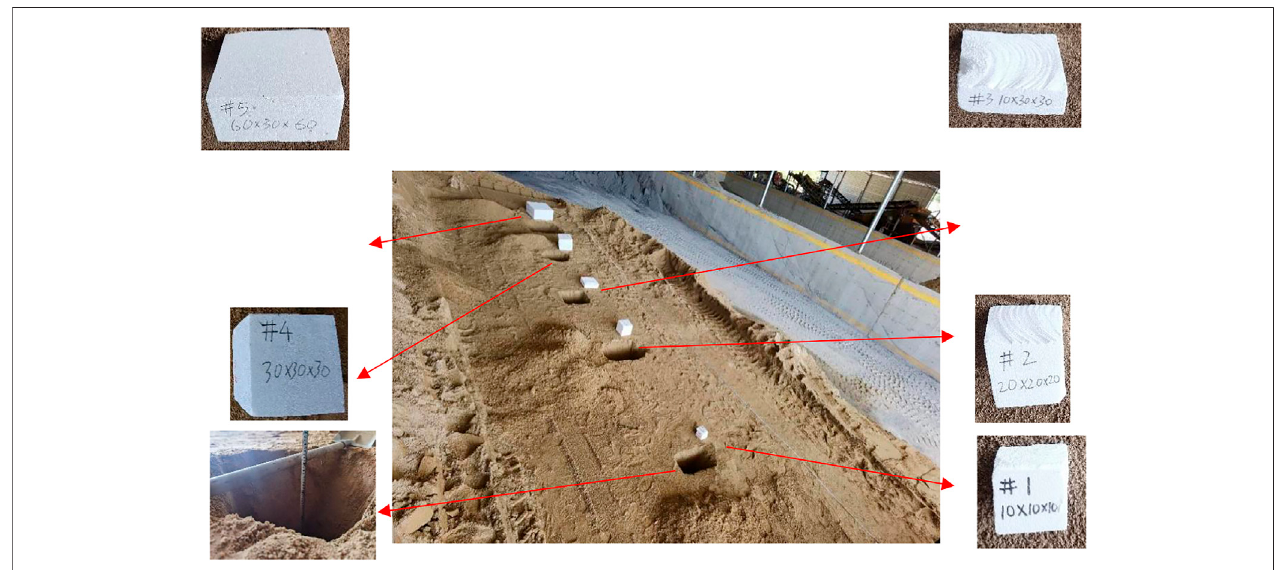
FIGURE 9 | Embedding and scanning of polystyrene cubes in the test